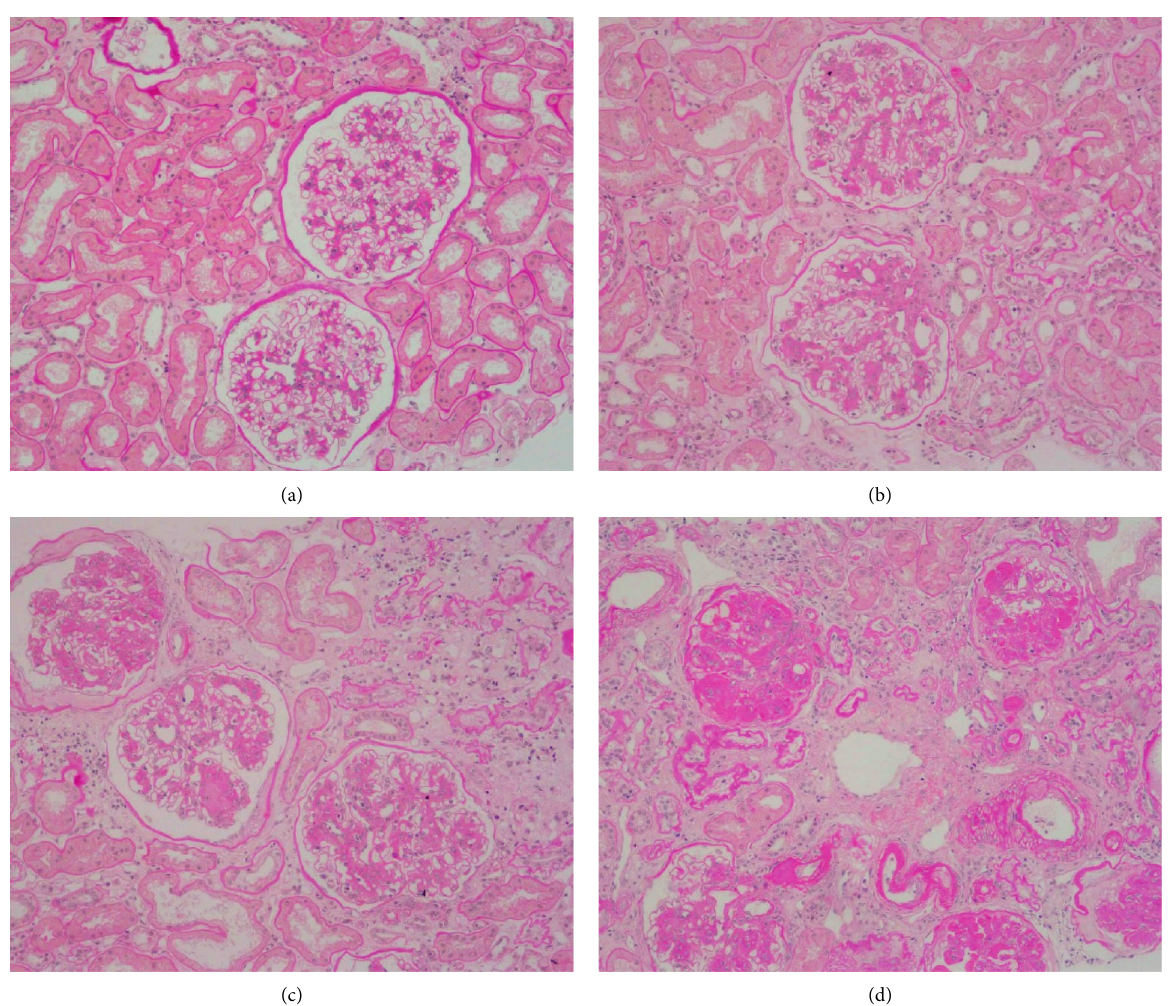
Figure 2: Representative images of renal pathology from patients with DN using the PAS stain ( × 200). (a) DN stage IIa: mild mesangial broadening. (b) DN stage IIb: severe mesangial broadening. (c) DN stage III: nodular glomerulosclerosis (Kimmelstiel–Wilson nodules). (d)